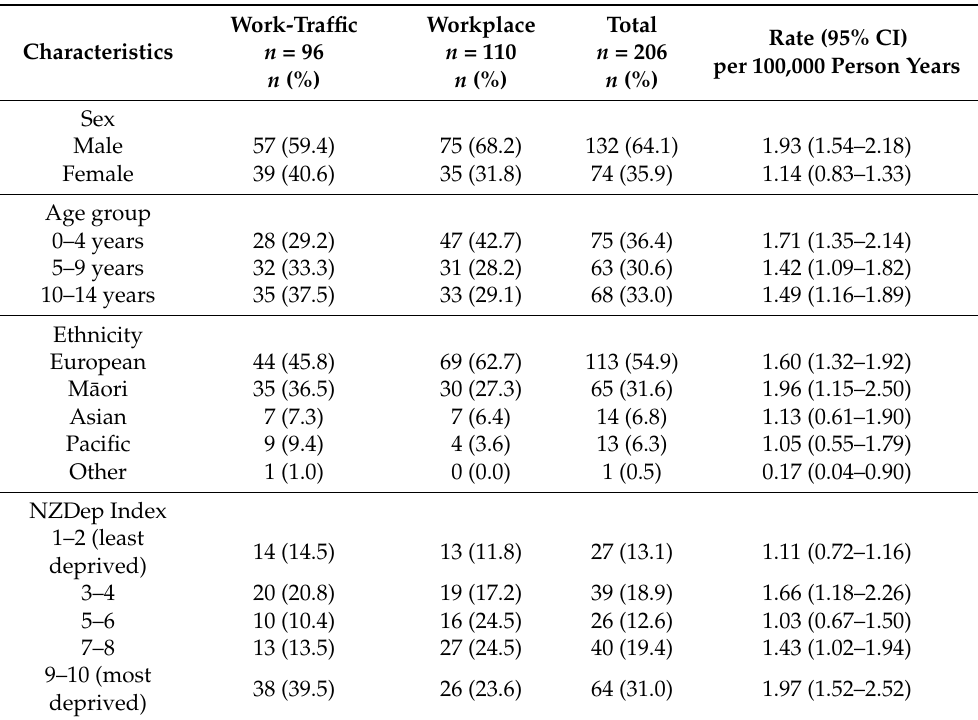
Table 2. Socio-demographic characteristics by location of injury, work-related fatalities to children (0–14 years), New Zealand,